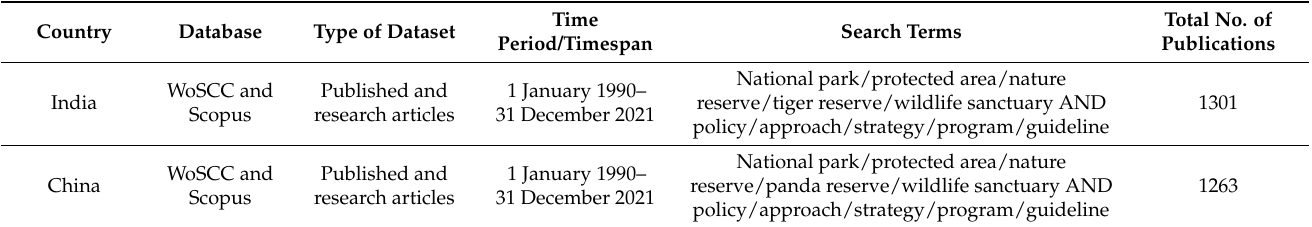
Table 1. Search strategies for India and